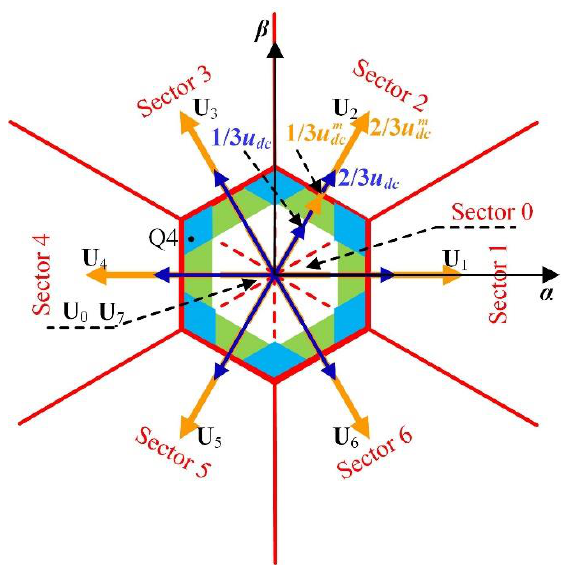
Figure 4. Distribution of reference voltage vector with over-voltage measurement.